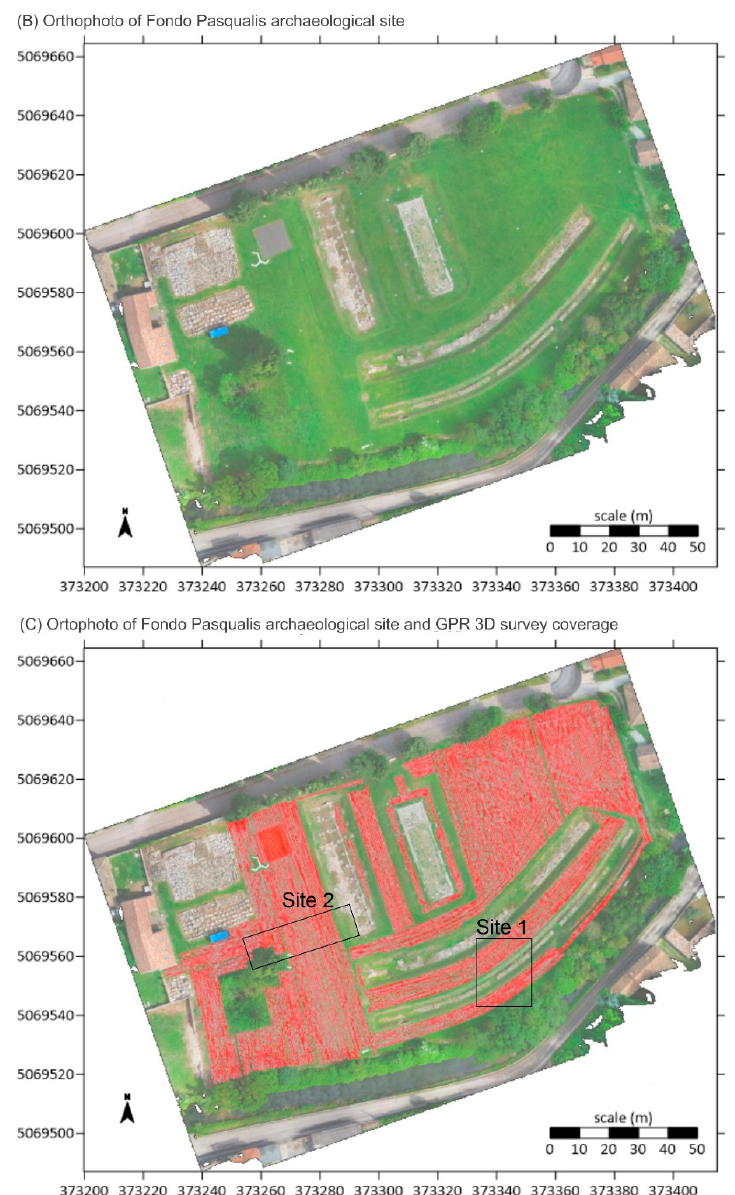
Figure 1. ( A ) Location of the Roman city of Aquileia and aerial view of the survey area; ( B ) Or- thophoto of the Fondo Pasqualis archaeological site before the new archaeological excavation, geo- referenced with the ETRS89/UTM zone 33 Nord (EPSG:25833) coordinate system; ( C ) the red lines represent the 3-D GPR coverage